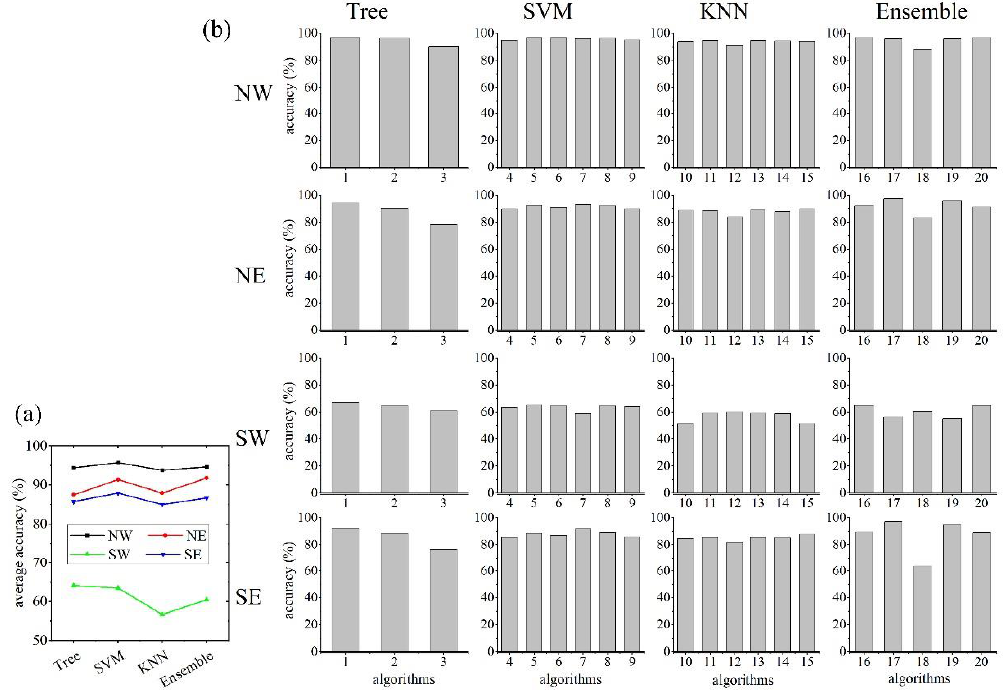
Figure 7. The classification prediction accuracy for the four glaciers using the machine learning algorithms of the classifier classes in the MATLAB Classification Learner module. ( a ) The average prediction accuracy of the four classifier classes for four glaciers. ( b ) The prediction accuracy of the 20 MATLAB machine learning classification algorithms for the four glaciers. Each row represents one glacier, and each column corresponds to one classifier class. See Table 3 for the correspondence between algorithm number and name.